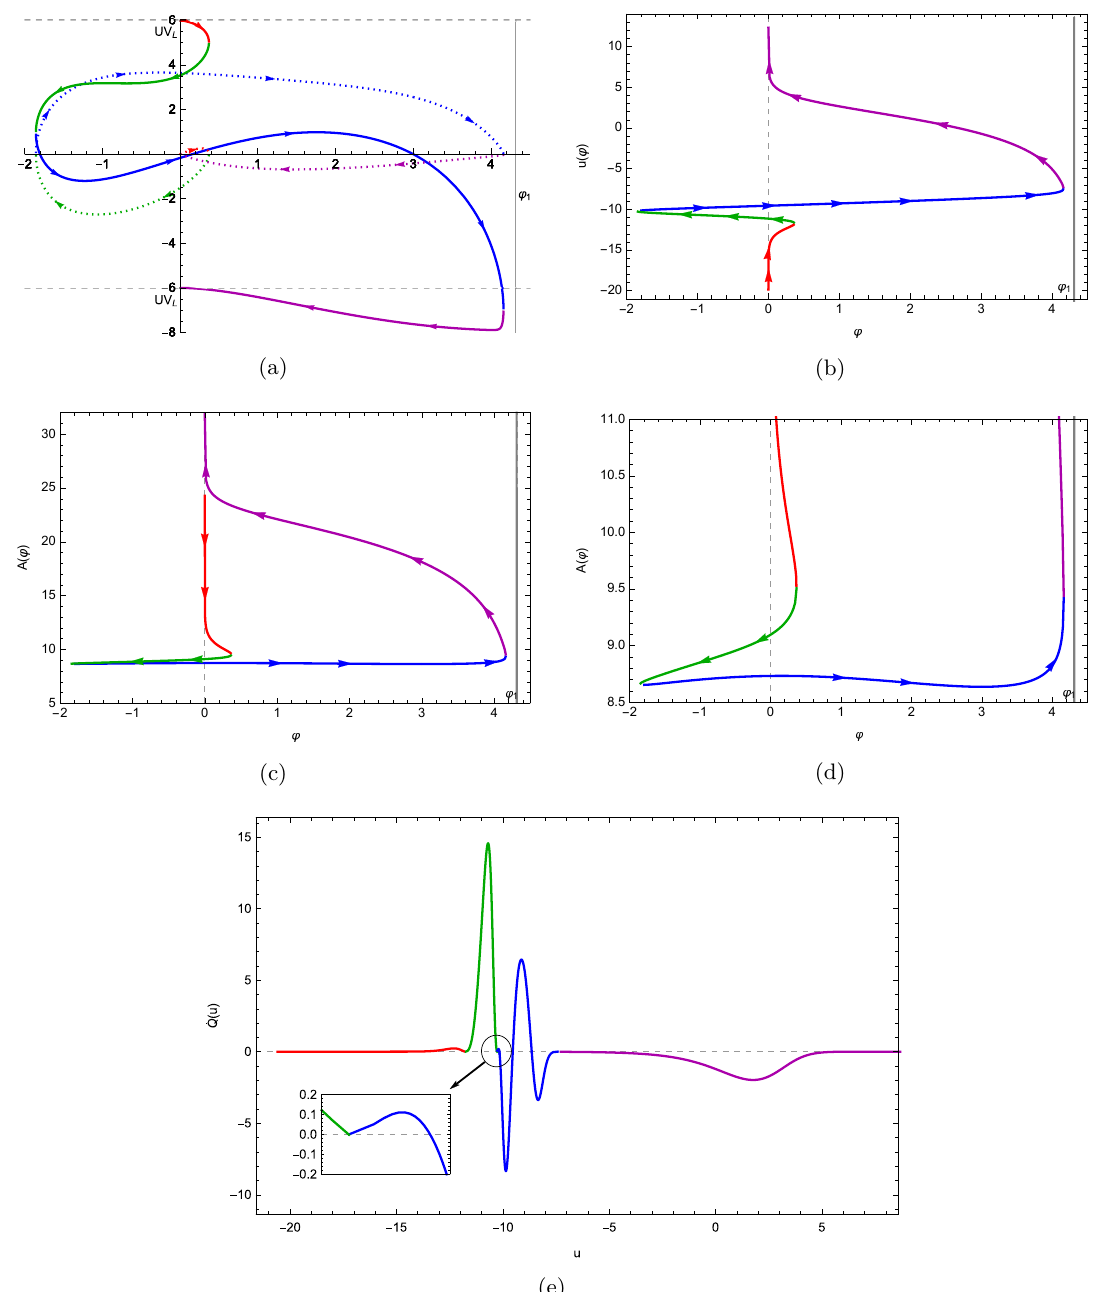
. The solid line is W ( ϕ ) and dotted Figure 34 . (a): an example of a multi- ϕ -bounce solution, W LL 3 , 3 line is S ( ϕ ) . In this case, a flow connects two UV boundaries on the left UV fixed point after three ϕ -bounces. Unlike the previous cases, the geometry here has three A-bounces. (b)and (c) show the behavior of holographic coordinate and scale factor in terms of ϕ . Figure (d) is the magnification of the bottom of figure (c). It shows that there are three A-bounces for this flow. (e): the roots of ˙ Q in equation (3.13) shows the location of ϕ -bounces where the color of the graph is changed and the location of A-bounces where the blue part of the curve crosses the u